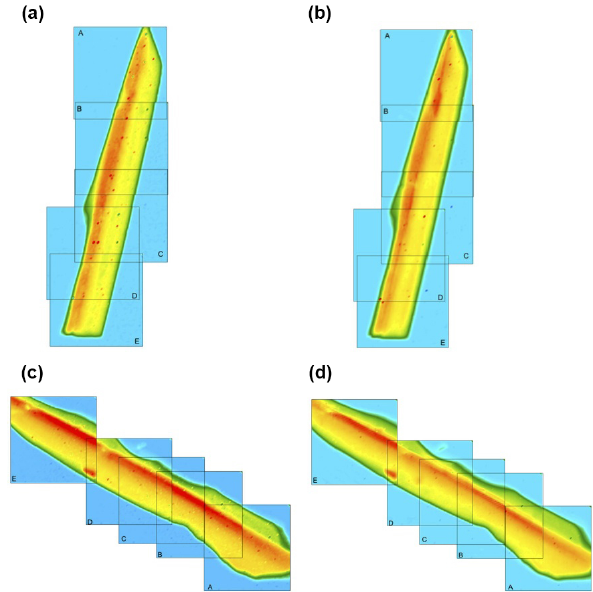
Figure 3. Water distribution in two bubble wall fragments: (a– b) TPRT1 and (c–d) TPRT2. (a) and (c) show absorbance of the 3567cm − 1 band, and (b) and (d) show absorbance of the 1628cm − 1 band. The composite reconstruction is made of FTIR images of 350 × 350µm (for each box). Note that the red areas sug- gest high water concentration but reflect thicker glass due to the intersection of two bubble walls; here, we use the homogeneous yel- low distribution in the parallel portion of the bubble wall (for which we measured the thickness) to determine water